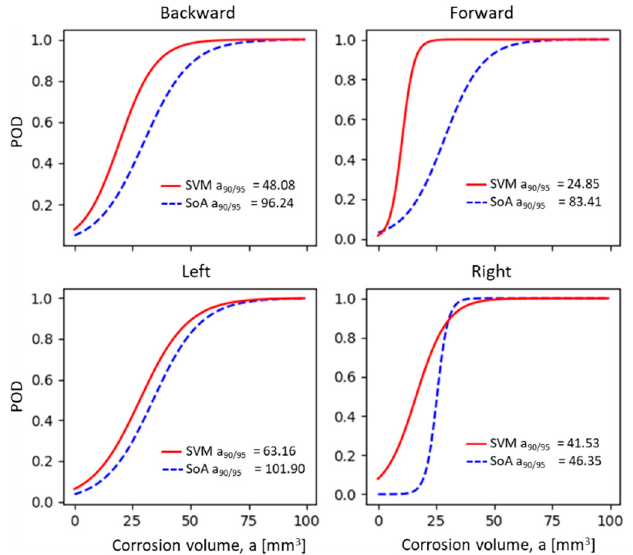
Figure 14. POD curves comparison between SVM and SoA method [22]. SVM model used only 20% of the data for training at a small volume range (P 2 :15.0 to 25.4 mm 3